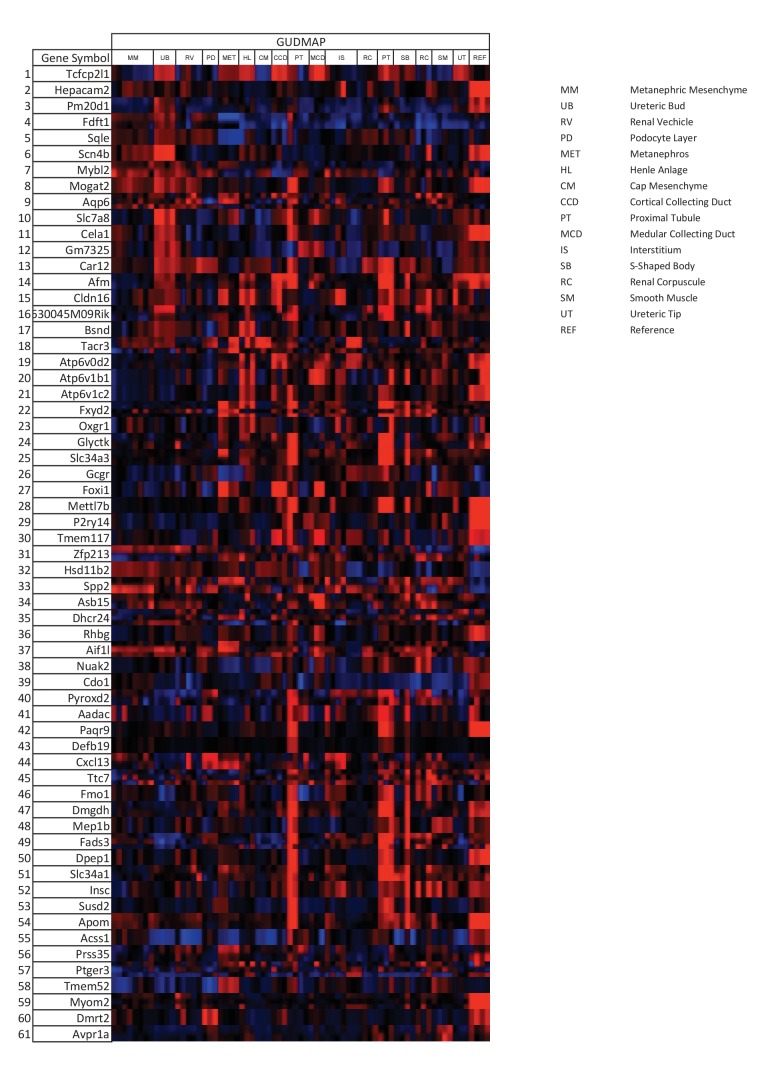
Tfcp2l1 dependent genes localized to the collecting duct.Genes that were significantly downregulated by the knockout of Tfcp2l1 (EIIA-Cre;Tfcp2l1f/f;>1.25 fold downregulation; p<0.05; n = 3 independent knockout and wild type mice) were localized with the help of GUDMAP (http://www.gudmap.org/). Most of these genes appeared to be highly expressed by the Ureteric Bud (UB), the Loop of Henle (HL), the cortical and medullary collecting ducts (CCD and MCD, respectively), and to a lesser extent by the proximal tubule, parallel with the expression pattern of endogenous Tfcp2l1 (top row). Red color indicates expression; Blue color indicates no expression.